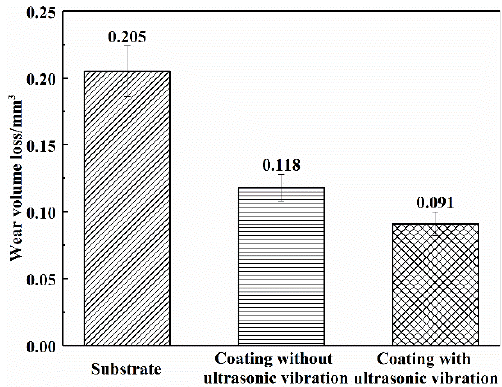
Figure 11. Wear volume loss of the substrate and coatings.